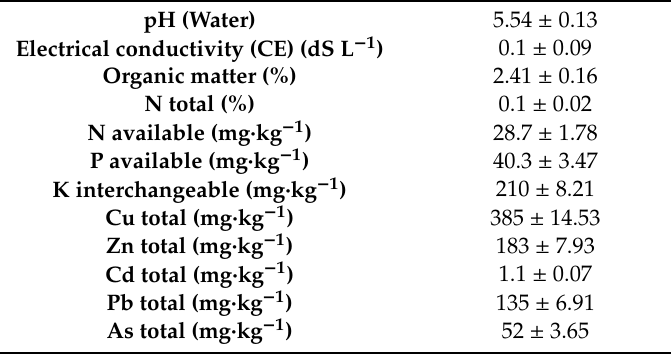
Table 1. Chemical analysis of the soil sample from the Puchuncav í